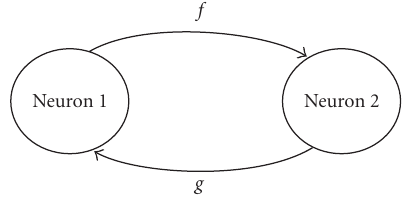
Figure 4.1. The model of two-neuron